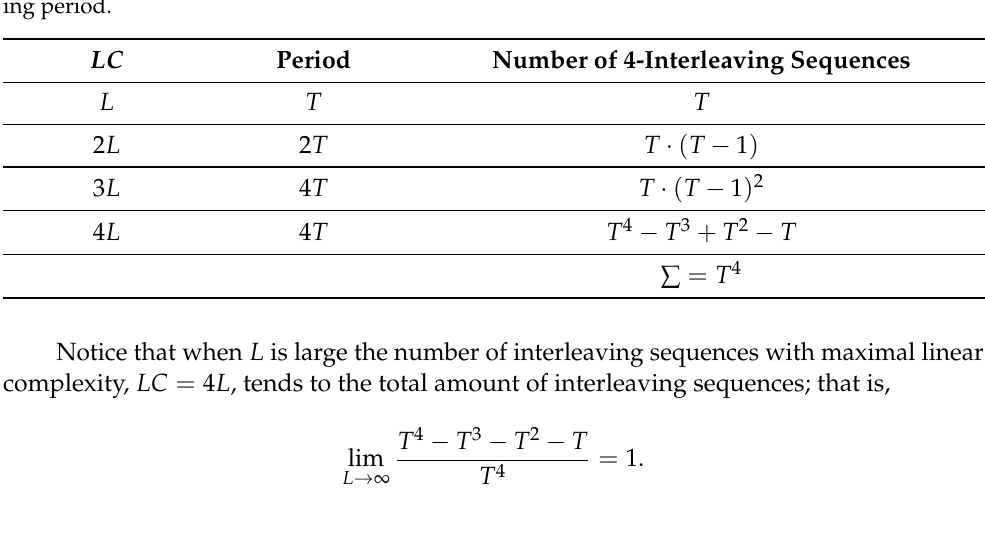
Table 1. Number of 4-interleaving sequences with LC = L , 2 L , 3 L and 4 L and the correspond- ing